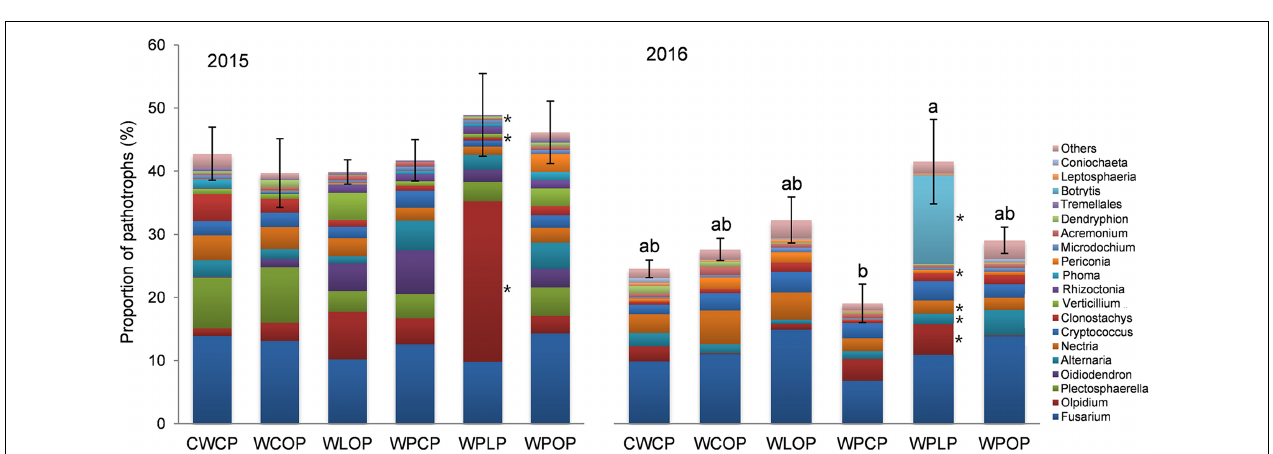
FIGURE 9 | Effect of cropping system on the abundance of fungal genera ( > 0.25% of total reads) assigned to trophic mode of pathotrophs (mean ± SE) in 2015 and 2016. The effect of cropping system was insignificant in 2015. Bars with different letters indicate a significant difference in the proportion of pathotroph reads between cropping system ( P < 0.05). Different color bar of fungal taxa with an ∗ indicates a significant effect of cropping system on the proportion of pathotrophs’ reads at P < 0.05.